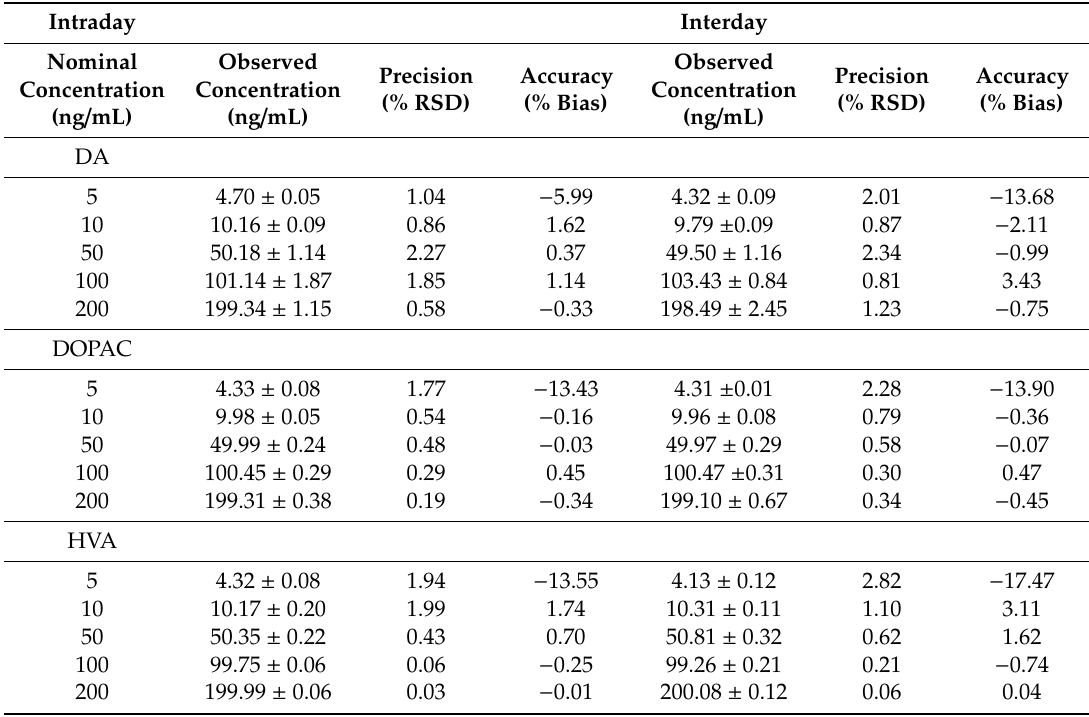
Table 1. Method validation for the intra-assay precision (% RSD) and accuracy (% Bias) of the HPLC method for the determination of DA, DOPAC and HVA in the